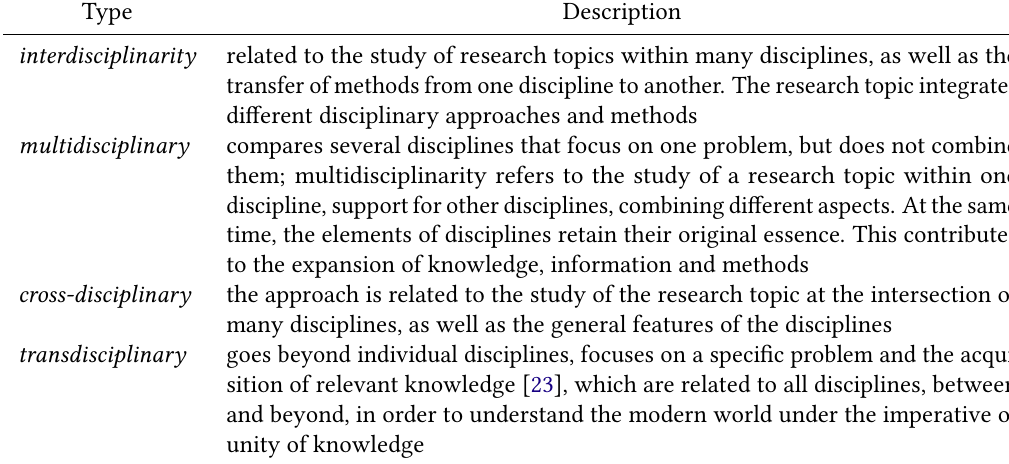
Table 1 Types of interdisciplinary